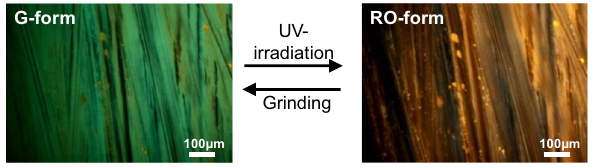
Figure 2. FL microscope images of DSP crystals in G- and RO-forms.